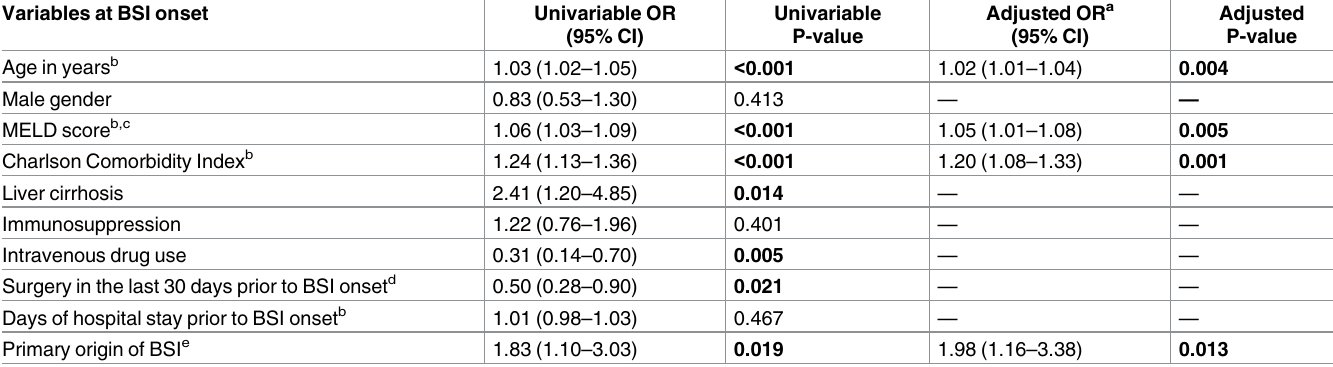
Table 2. Predictors of 30-DayAll-Cause Mortality in Patients with Staphylococcus aureus Bloodstream Infection (n = 561); Univariable and Multi- variable Analyses. Variables at BSI onset